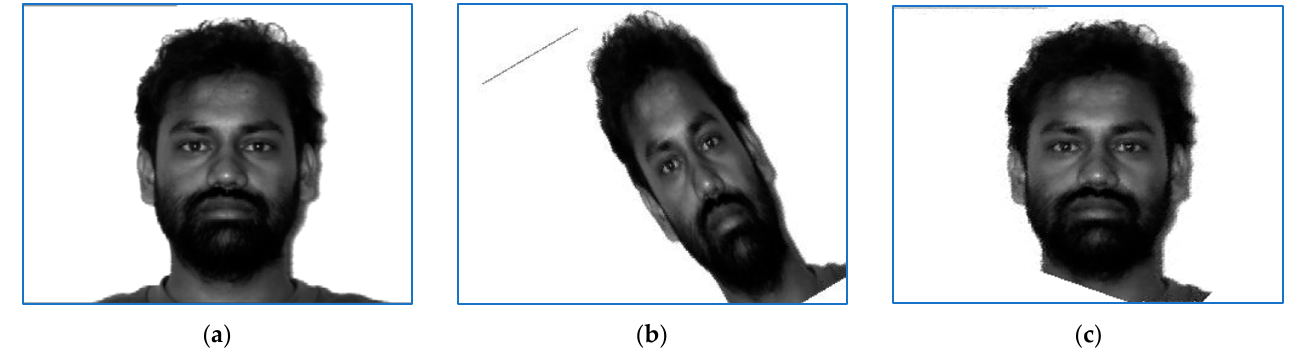
Figure 2. Images of subject 7: ( a ) target image, ( b ) sensed image, and ( c ) correctly restored image. Figures 3 and 4 represent scaled and binarized variants of the images from Figures 1 and 2, computed by Algorithm 2.